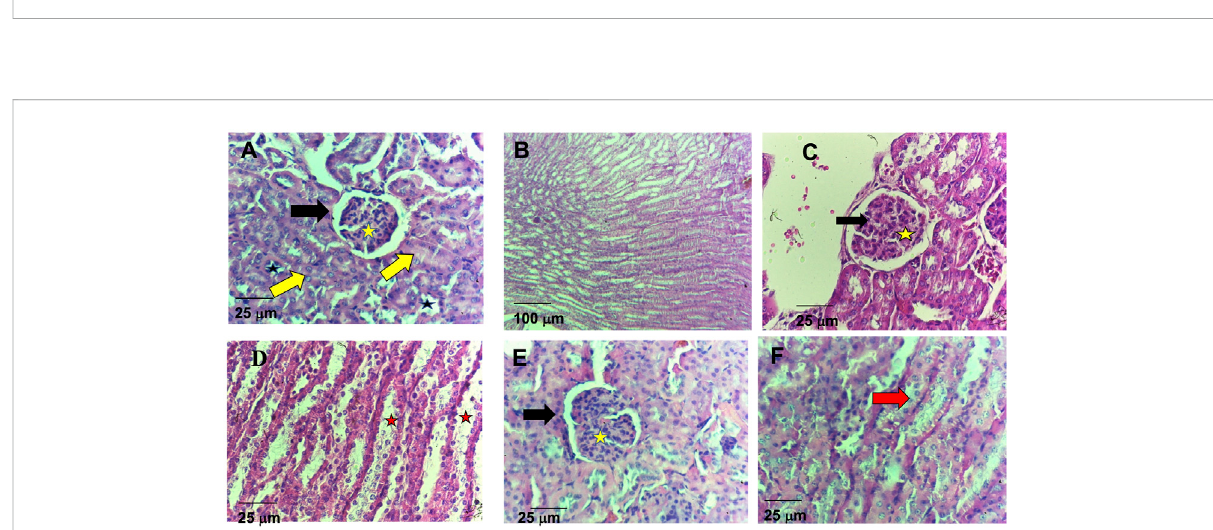
FIGURE 6 Histological study on liver of Ehrlich ascites carcinoma-bearing mice exposed to ACS-AZ (50 mg/kg) or 5-FU (25 mg/kg) by intraperitoneal route for 7 days. (A,B) Control. (A) Hepatocyte vacuolation (black circle). (B) Connective tissue areas in the portal region (black star). (C,D) Group 5- FU. (C) Preserved cords of hepatocytes. (D) Connective tissue areas in the portal region (black star). (E,F,G,H) Group ACS-AZ (50 mg/kg). (E) Hepatocyte vacuolation (black circle). (F) Connective tissue areas in the portal region (black asterisk) (G) Hepatic necrosis (yellow arrow). (H) mild in fl ammatory in fi ltrates (yellow arrow). (A,C,E,G,H) - HE 400x; (B,D,F) – Gomori ’ s trichrome. 400×. ACS-AZ: N ’ -(6-chloro-2-methoxyacridin-9- yl)-2-cyanoacetohydrazide; 5-FU: 5- fl uorouracil.